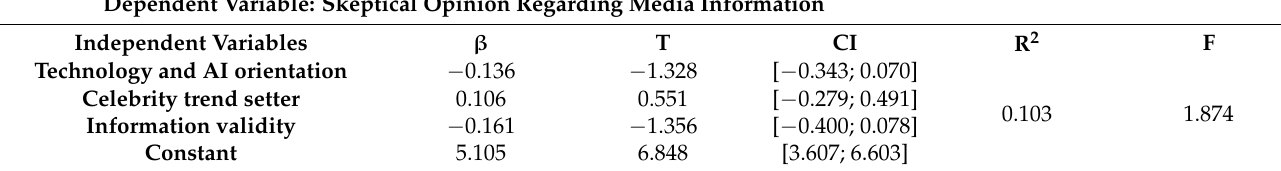
Table 6. Regression model for cluster